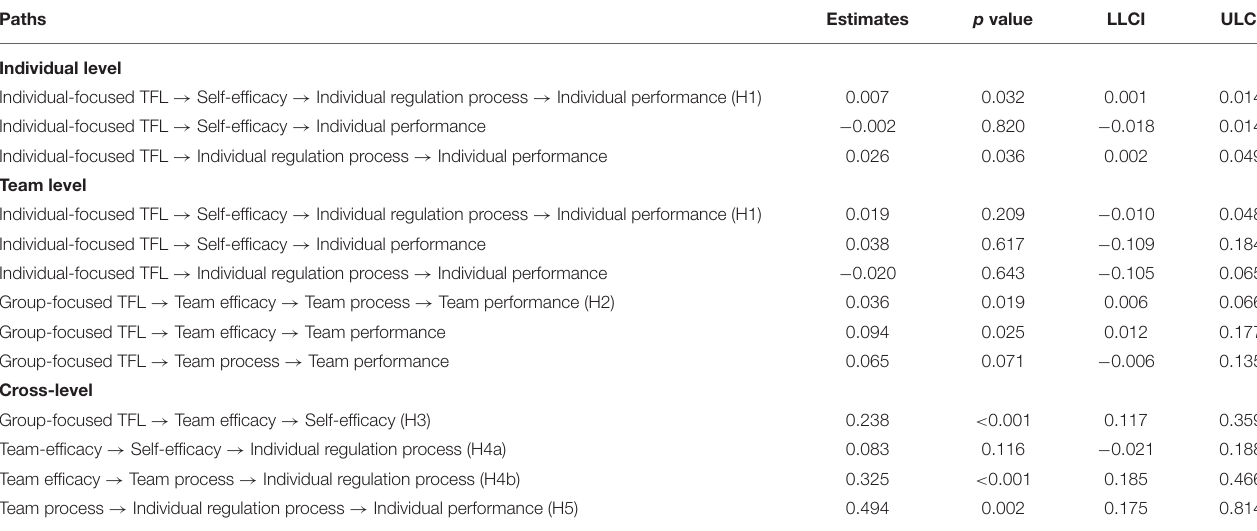
TABLE 5 | Unstandardized estimates of indirect effects without control variables.